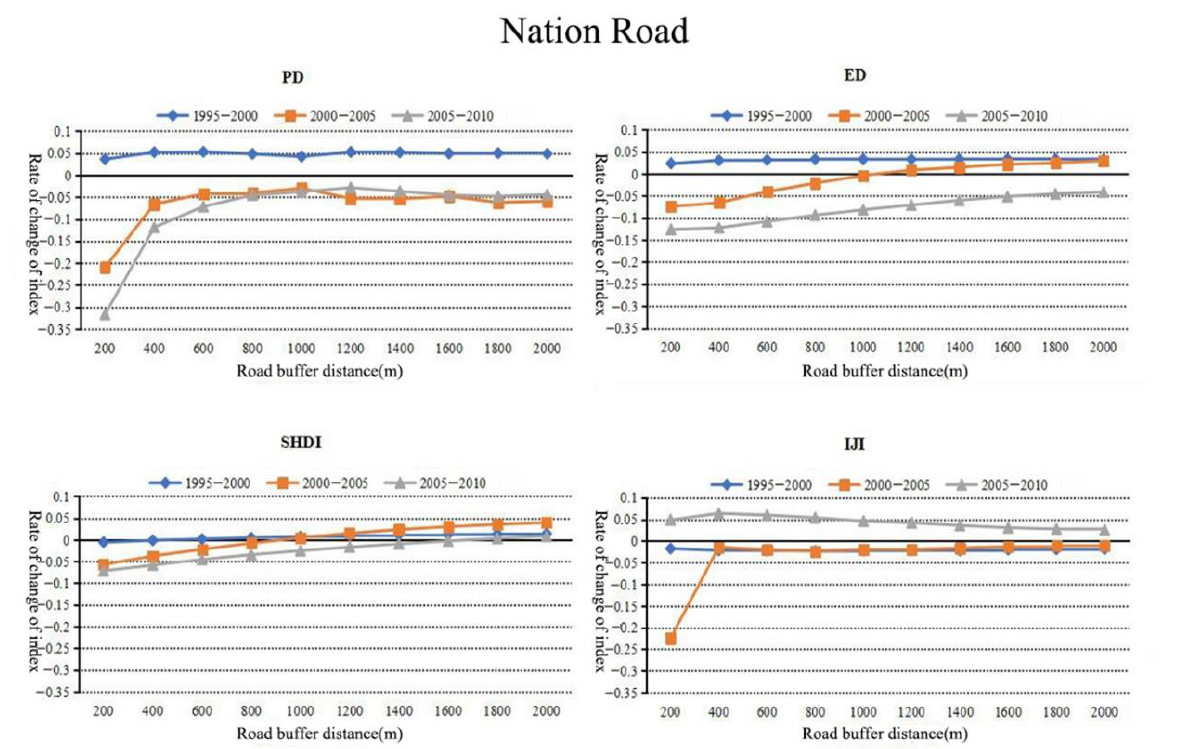
Remote Sens. 2022 , 14 , x FOR PEER REVIEW